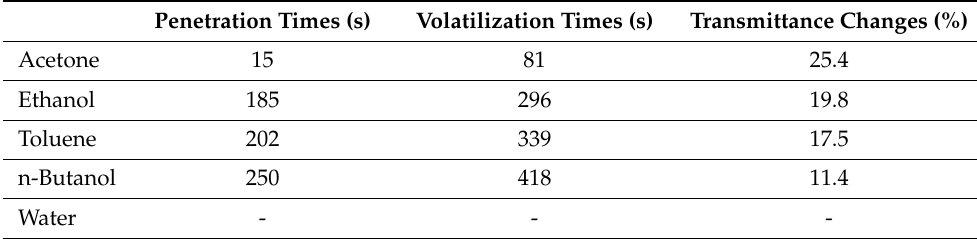
Table 1. Comparison of the patterned PDLC films with a thickness of 50 μm that were exposed to acetone, ethanol, toluene, n-butanol, and water.